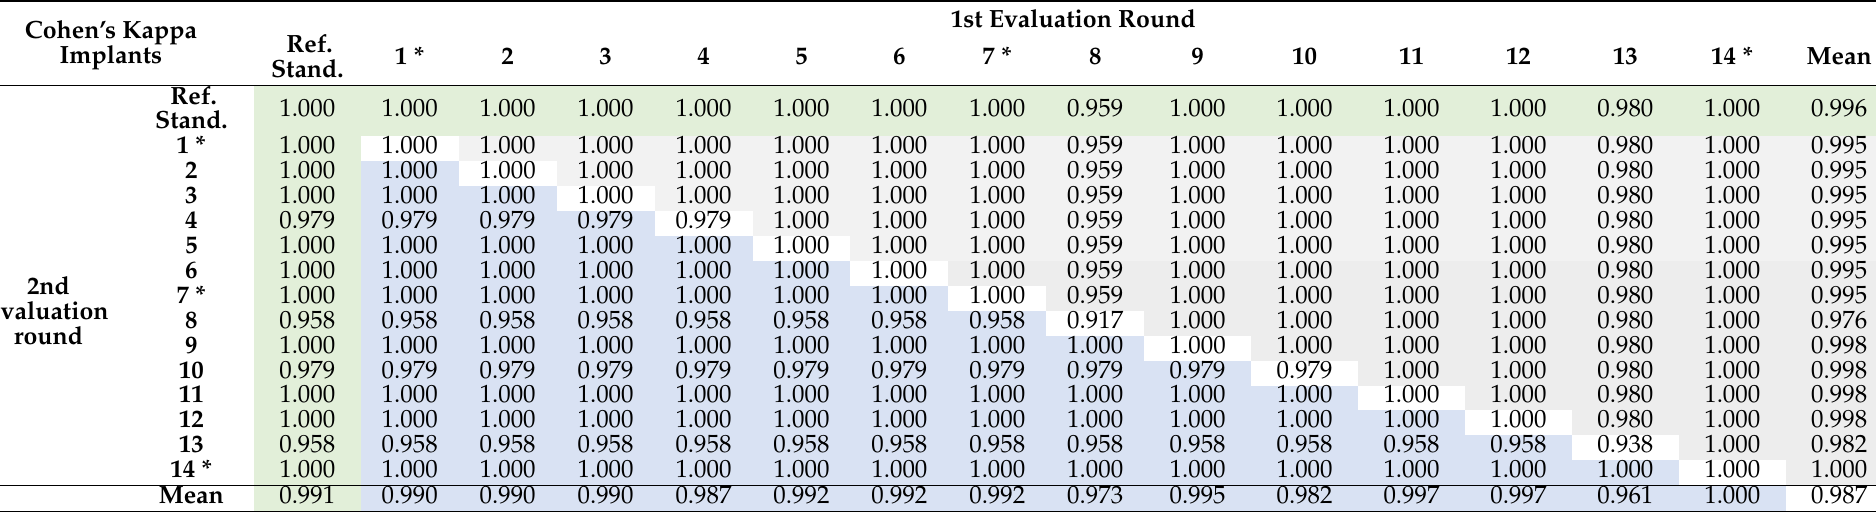
Table 4. Inter- and intra-examiner reliability values for the detection of dental implants between all examiners (N = 14) and in relation to the reference diagnosis (green background color). Gray background colors indicate inter-examiner CK values of the first evaluation round and blue background colors for the second evaluation round. Fields with a white background color represent intra-examiner CK